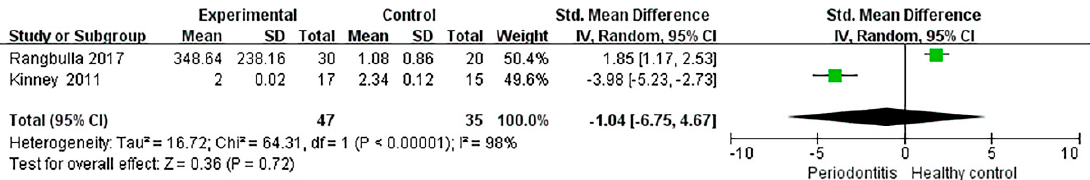
Figure 3. Effects on salivary MMP-8 after non-periodontal surgery therapy. Note: green color, random effect interval in each study; black, total effect. 4. Discussion Dental professionals meet patients who are on the verge of losing a large number of teeth. The oral condition of the patients makes both the dental professionals and the pa- tient very unfortunate. In order to prevent the condition, it is important to visit the dentist regularly for examinations and accurate diagnosis. For accurate diagnosis, periodontists conduct radiological and hand-instrument examinations. However, the clinical diagnosis by hand instrument examination is a time-consuming and difficult to both dental profes- sionals and patients because all teeth must be assessed and recorded. Radiological exam- ination may result in undiagnosed areas due to overlapping structures. Although these methods are generally used for clinical diagnosis of periodontal disease, it has the disad- vantages of providing past disease and limited information on the progress of future per- iodontal disease. Therefore, a test kit for identifying bacteria and a system for testing for genetic factors related to periodontal disease has been reported. These new examination methods are difficult to alternate radiographic and hand-instrument examination, but their necessity is increasing in diagnostic examinations. During periodontal disease, host inflammatory cells are recruited, and inflammatory cytokines, such as IL-1 β , IL-6, and TNF- α , are released from fibroblasts, macrophages, connective tissue, and junctional epithelial cells. Then host-derived enzymes, MMP-8, MMP-9, and calprotectin are released by PMNs and osteoclasts, leading to connective tis- sue and alveolar bone degradation [28]. Various biomarkers in saliva have been proposed as candidates for the diagnosis of periodontal disease. Bacterial factors and inflammatory responses by cytokines, chemo- kines, and various factors that can cause periodontal disease have been identified at the saliva level. Therefor this meta-analysis systematically evaluated the salivary IL-1 β and MMP-8 levels after SRP treatments in two independent studies, and the systematic review